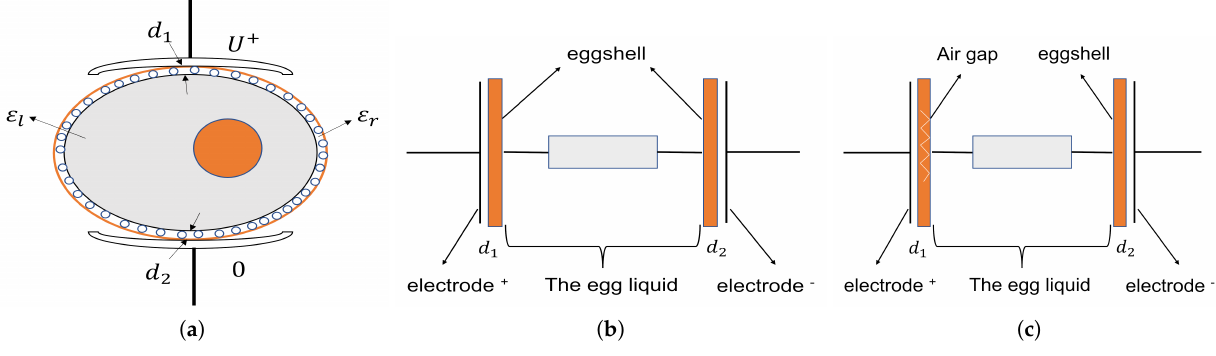
Figure 3. Capacitance system diagram. ( a ) Schematic diagram of the capacitor system, composed of the electrode and egg body. ( b ) Schematic diagram of equivalent capacitance of system when the electrode is not at the crack. ( c ) Schematic diagram of equivalent capacitance of the system when electrode is at the